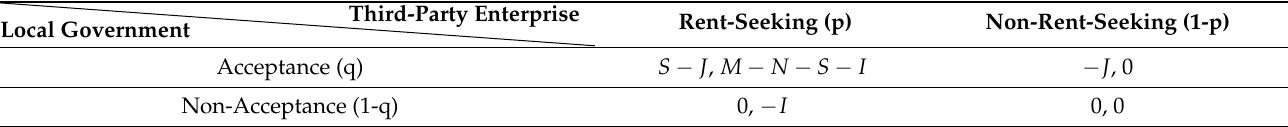
Table 2. The game matrix of the local government and the third-party enterprise. Third-Party Enterprise Rent-Seeking (p) Non-Rent-Seeking (1-p) Local Government Acceptance